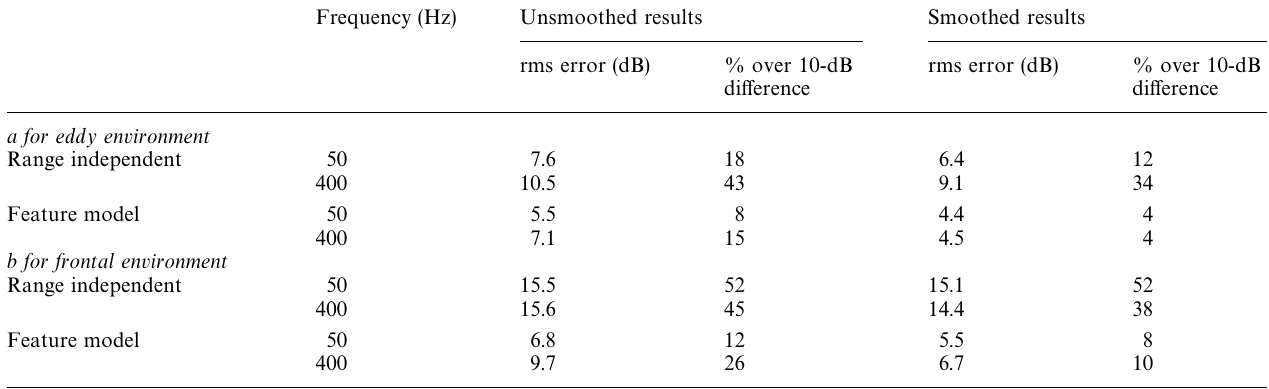
Table 2. Propagation loss error statistics Frequency (Hz) Unsmoothed results Smoothed results rms error (dB) % over 10-dB rms error (dB) % over 10-dB difference